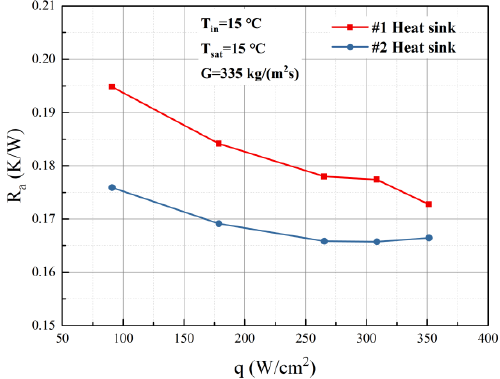
Figure 6. Trend of thermal resistance under different heat